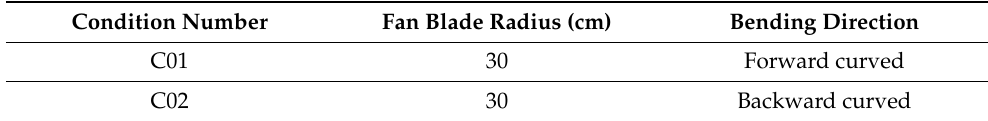
Table 5. Experimental setting of optimization of blade bending directions.